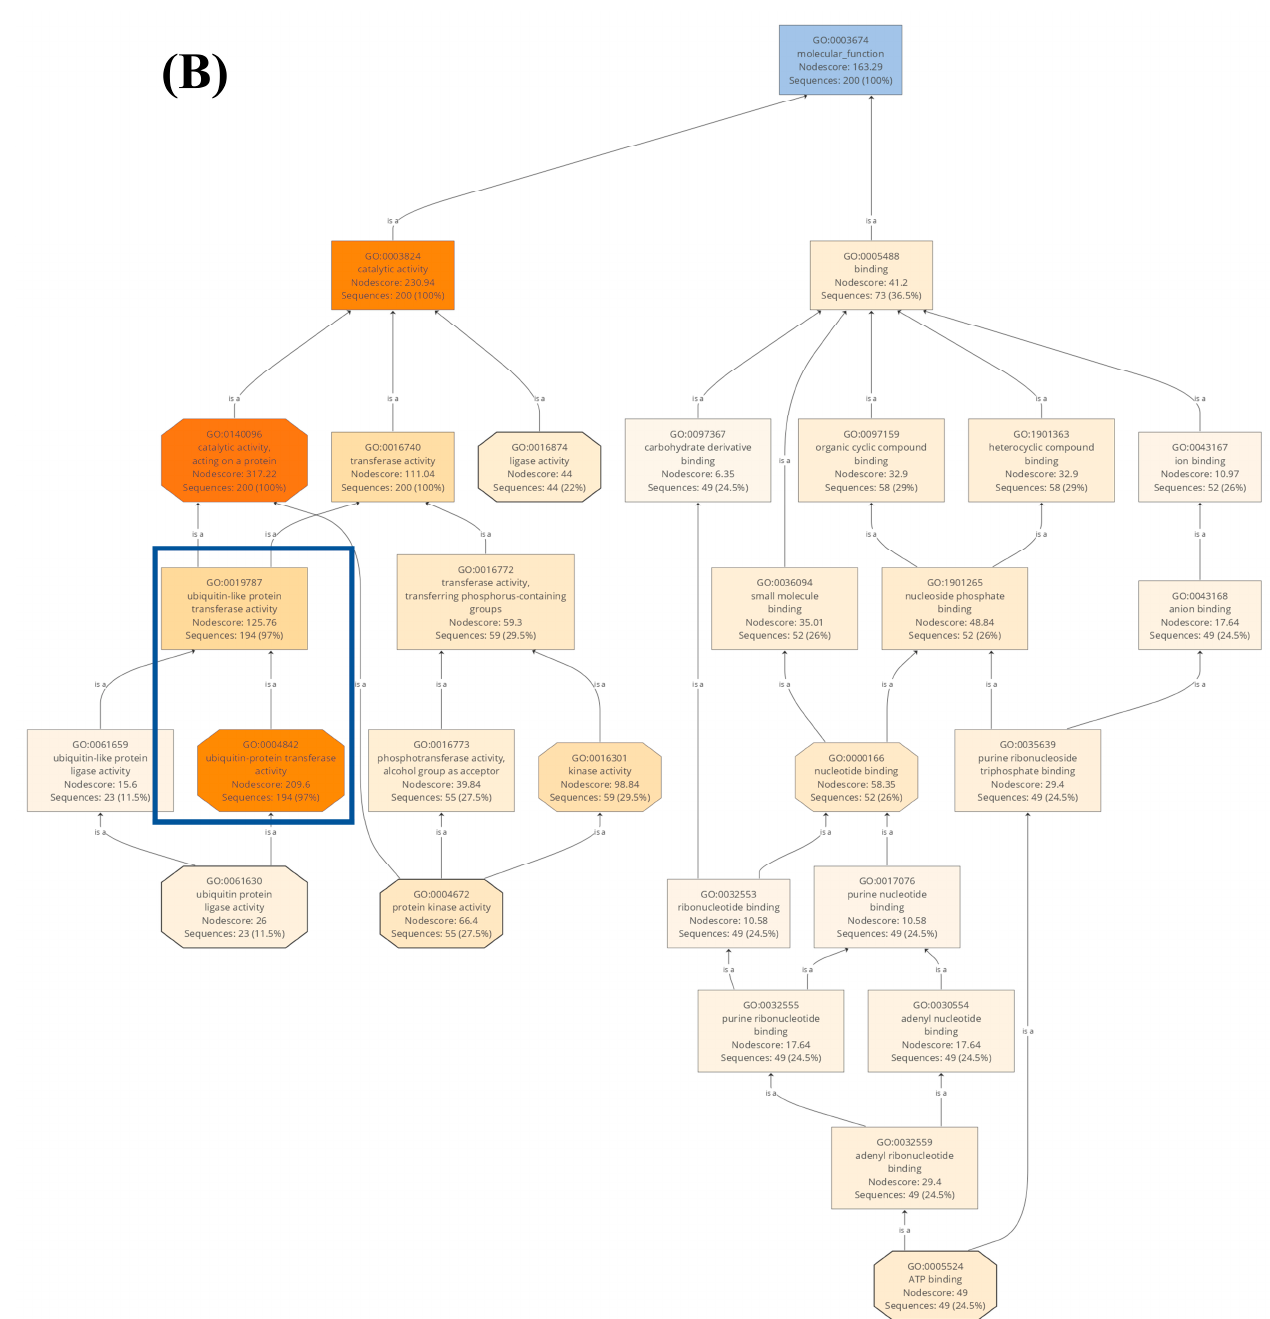
Figure 2. Gene ontology (GO) analysis of wheat U-box E3 genes. GO terms of U-box E3 genes were in the categories “biological process” ( A ) and “molecular function” ( B ). Red and blue boxes in ( A , B ) indicate that most of the selected U-box E3 genes have the function “protein ubiquitination” in biological process and molecular function, respectively.